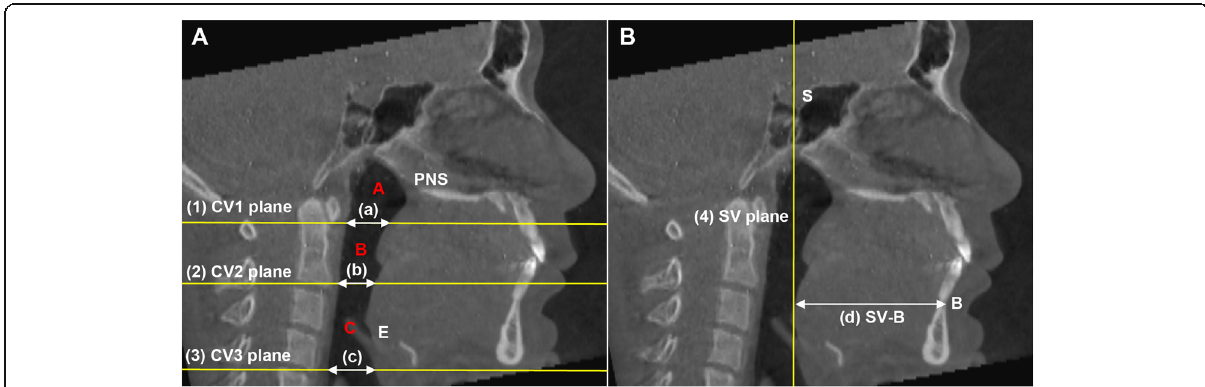
Fig. 1 Pharyngeal airway division and measurements. a The airway space divided into three areas based on reference planes. (1) a plane parallel to the FH plane passing through CV 1 ; (2) a plane parallel to the FH plane passing through CV 2 ; (3) a plane parallel to the FH plane passing through CV 4 ; A, the nasopharyngeal volume; B, oropharyngeal volume; C, hypopharyngeal volume; (a) nasopharyngeal antero-posterior distance; (b) oropharyngeal antero-posterior distance; (c) hypopharyngeal anteroposterior distance. b Measurement of SV-B. (4) sella vertical plane; (d) the distance from the sella vertical plane to the B point. PNS posterior nasal spine